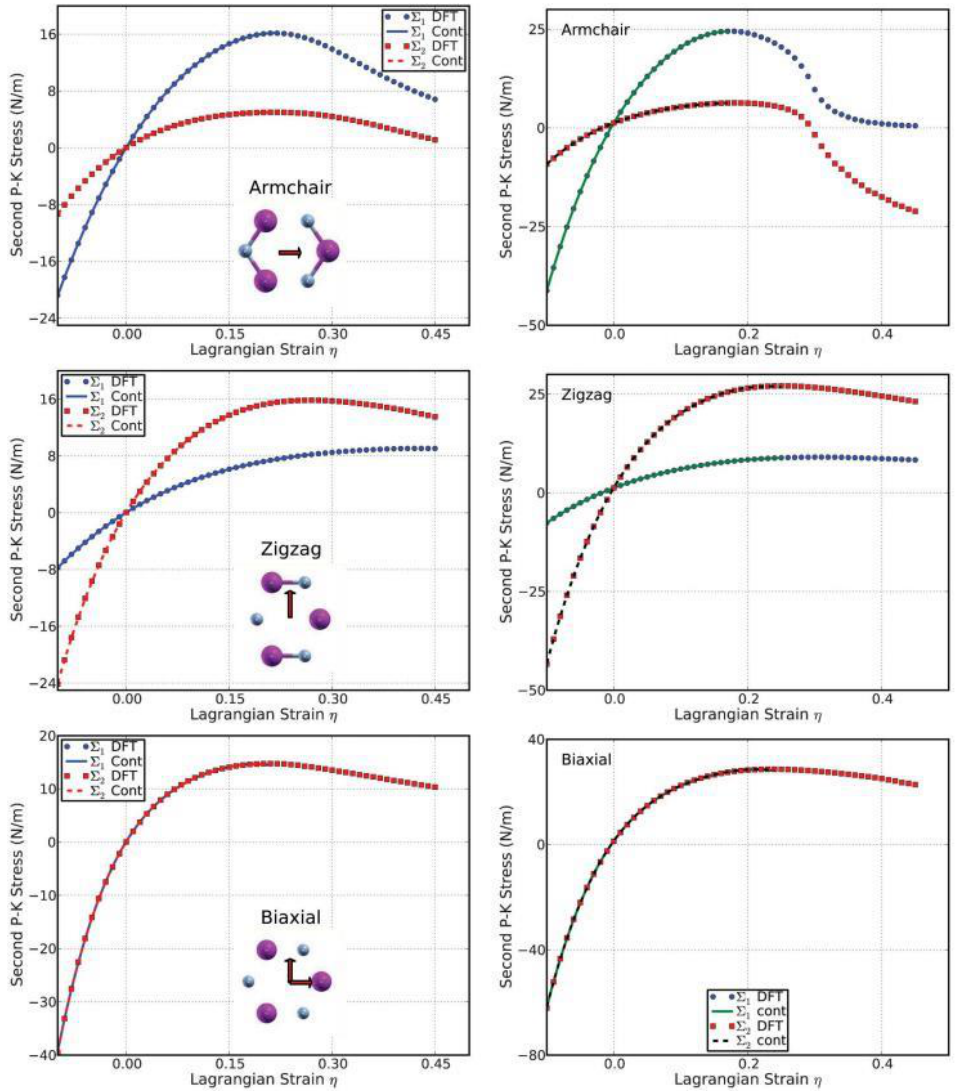
Figure 10. Stress–strain responses of g-AlN ( left ) under the armchair, zigzag, and biaxial strain, compared with g-BN ( right ). Σ 1 ( Σ 2 ) denotes the x (y) component of the stress. “Cont” stands for the fitting of DFT calculations (”DFT’’) to continuum elastic theory.